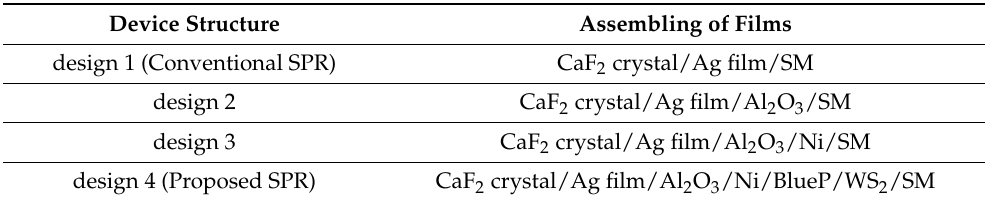
Table 2. Comparative study of the proposed SPR